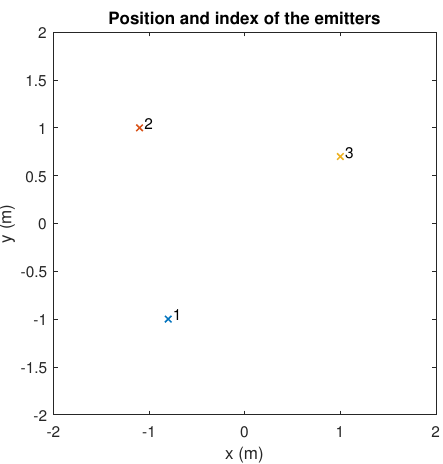
Figure 15. Position and index of the different emitters.